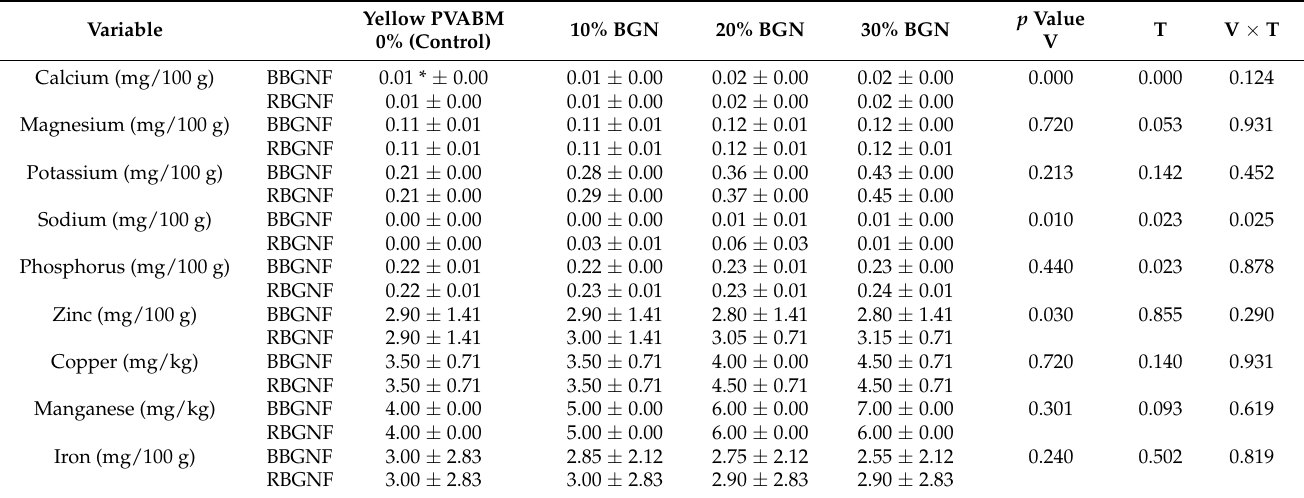
Table 7. The mineral element content of the BGN-PABM composite complementary instant porridges [dry basis